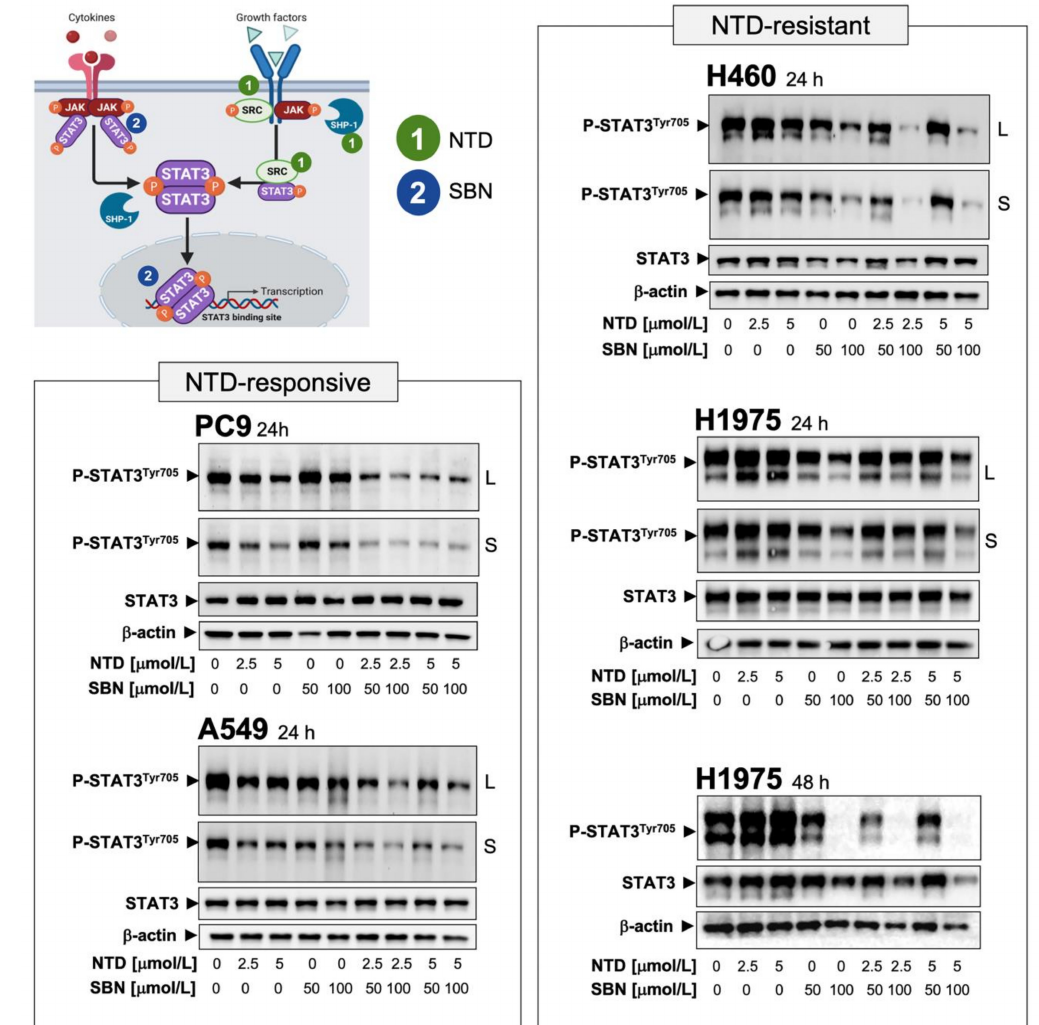
Figure 3. STAT3-targeted effects of the interaction between nintedanib and silibinin in NSCLC cells. Unstimulated STAT3 is activated by recruitment to phospho-tyrosine motifs existing within complexes of cytokine receptors (e.g., IL-6 receptor), growth factor receptors (e.g., EGFR, PDGFR, FGFR), or non-receptor tyrosine kinases (e.g., SRC) through its SH2 domain. STAT3 is then phosphorylated on the Tyr705 residue by activated tyrosine kinases (e.g., JAK, SRC) in receptor complexes. Phosphorylated STAT3 forms homodimers (and heterodimers with other STAT isoforms) and translocates to the nucleus, where STAT3 dimers bind to specific promoter elements of target genes to regulate gene expression via the STAT3 DNA-binding domain (DBD). Enhancing the activity of the SH2 domain-containing protein tyrosine phosphatase 1 (SHP-1) by the SHP-1 agonistic activity of nintedanib (NTD) can directly dephosphorylate STAT3 or its upstream JAKs to decrease the phospho-active STAT3 proteins (1). NTD might also inhibit STAT3 activity downstream of its direct actions on growth factor receptors such as PDGFR β and FGFR or non-receptor tyrosine kinases such as SRC (1). Silibinin (SBN) can directly bind to the (JAK and SRC-activated) SH2 domain of STAT3 to prevent Y705 phosphorylation-related STAT3